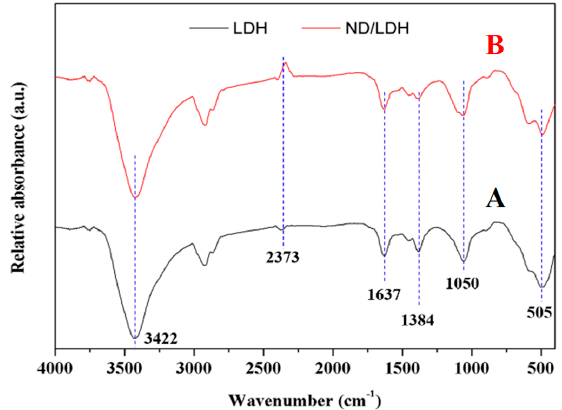
Figure 4. Fourier transform infrared (FTIR) spectra of LDH ( A ) and ND/LDH ( B ).